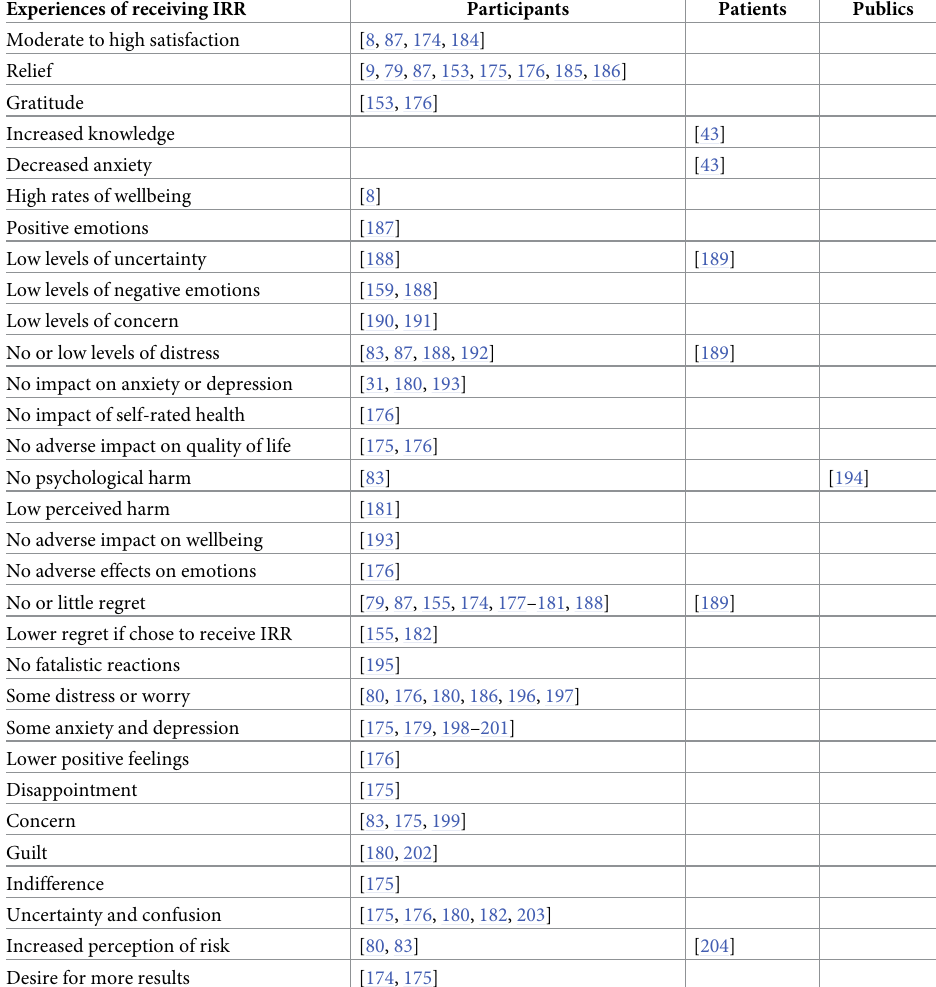
Table 6. Summary of experiences of participants, patients and public with receiving results.